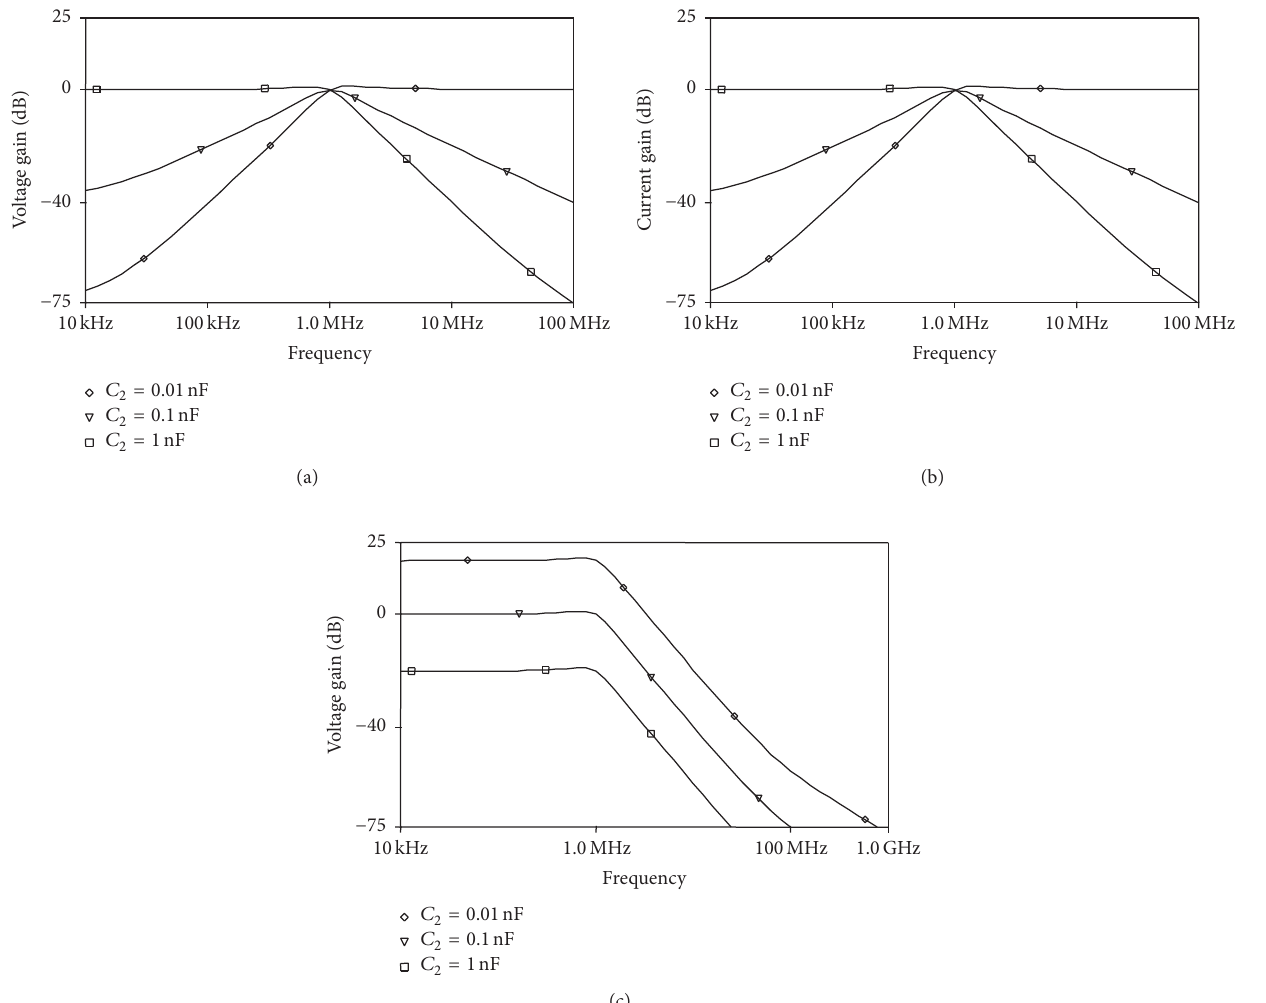
Figure 7: Frequency response at 𝑓 0 = 1 MHz and 𝑄 0 = 1 . (a) VM topology. (b) CM topology. (c) VM LP filter depicting gain tuning with 𝐶 2 .